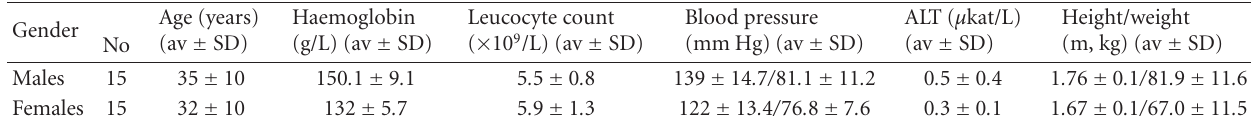
Table 3: Average values (with standard deviations) of other characteristics of blood donors.